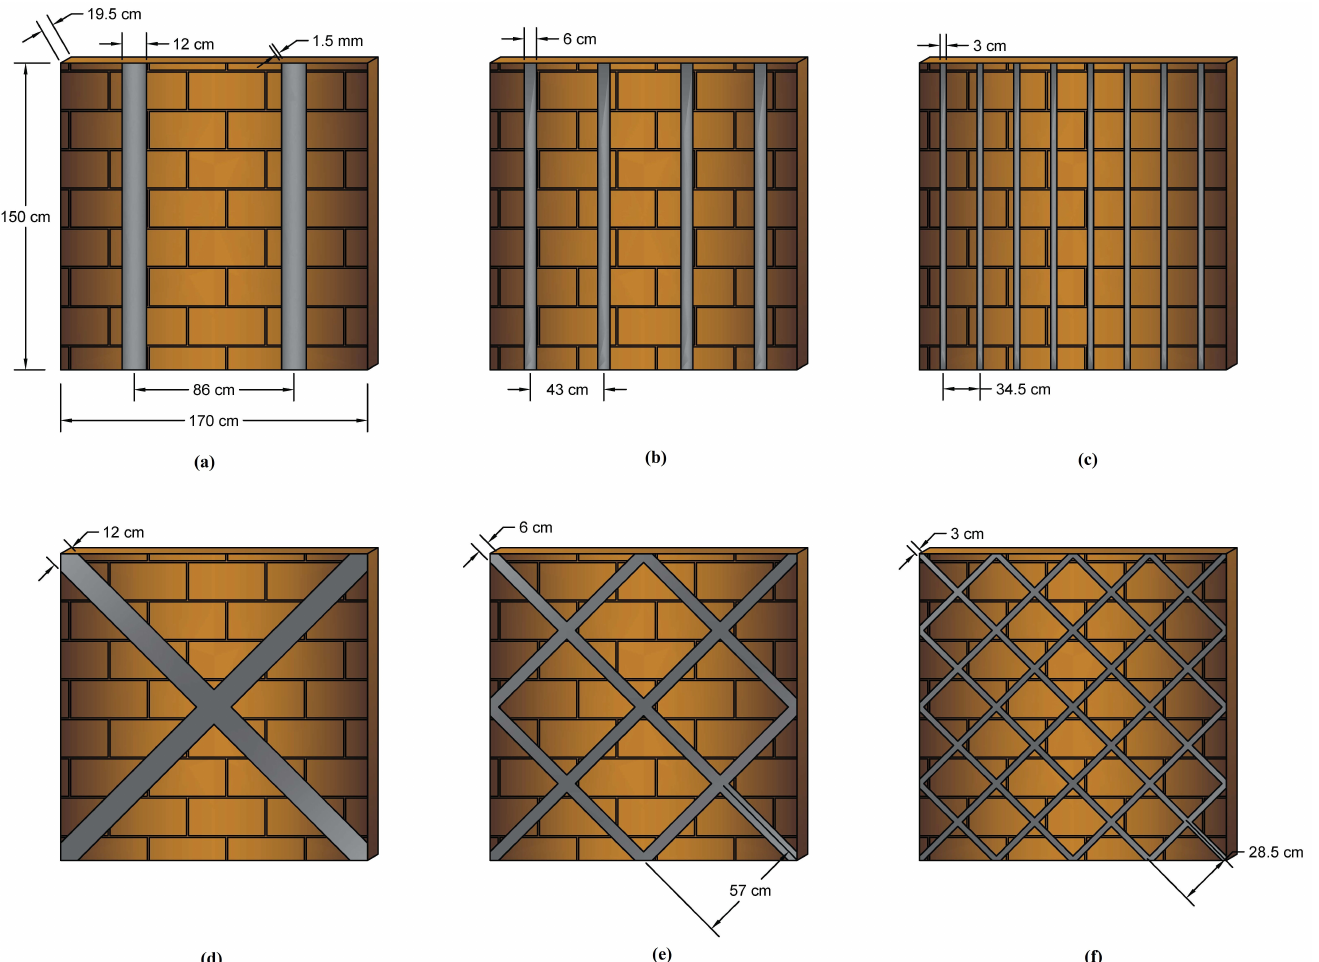
Figure 12. Numerically studied SMA-reinforced walls [63]; ( a ) 2 vertical stripes; ( b ) 4 vertical stripes; ( c ) 8 vertical stripes; ( d ) 2 cross-strips; ( e ) 6 cross-strips; ( f ) 14 cross-strips. Table 4. Energy dissipation of the wall specimens